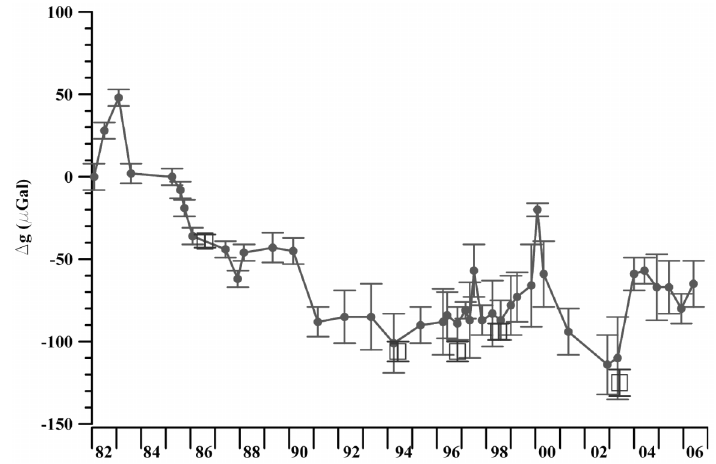
Fig. 8. Record of repeated relative (circle) and absolute (square) gravity measurements at